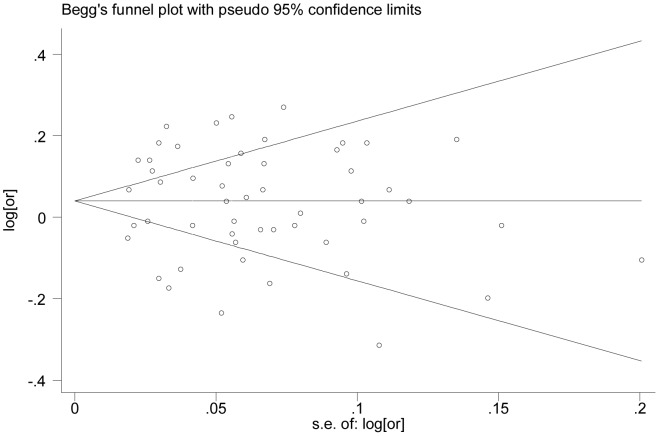
Funnel plot analysis to detect publication bias for the TERT-CLMPT1L polymorphism rs401681 in the involved 52 data sets.